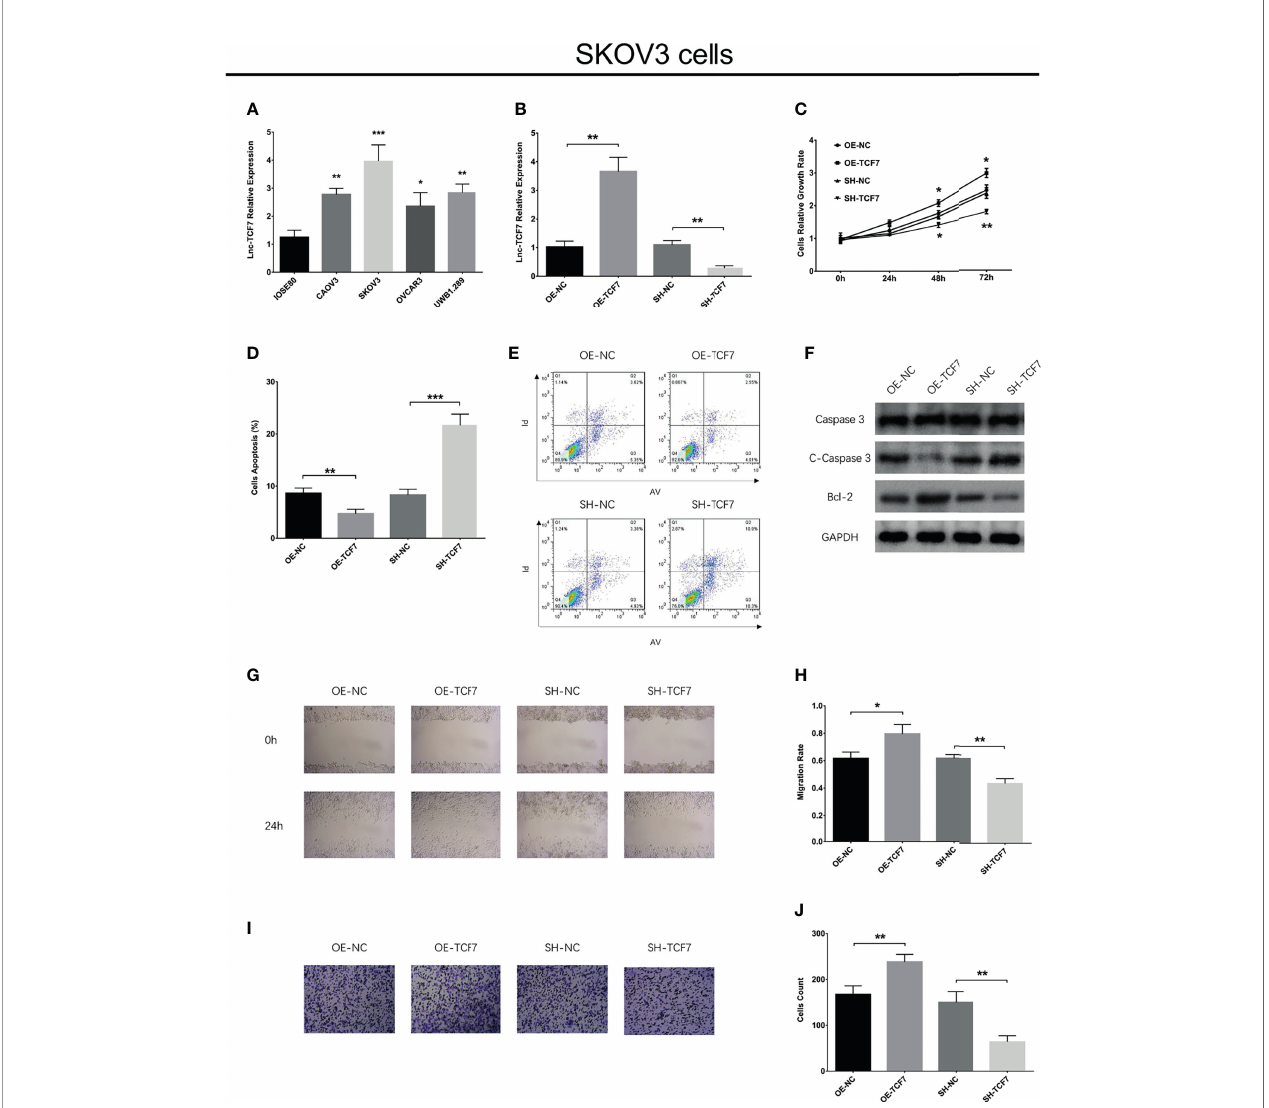
FIGURE 1 | Effect of lnc-TCF7 on cell proliferation, apoptosis, migration and invasion in SKOV3 cells. (A) The expression of lnc-TCF7 in EOC cells lines and normal ovarian epithelial cells; (B) The expression of lnc-TCF7 expression after transfection; (C) Cells proliferation in SKOV3 cells; (D, E) Cells apoptosis in SKOV3 cells. (F) Western blot; (G, H) Cells migration in SKOV3 cells; (I, J) Cells invasion in SKOV3 cells. Experiments were performed in triplicates. * represented P < 0.05, ** represented P < 0.01, *** represented P <